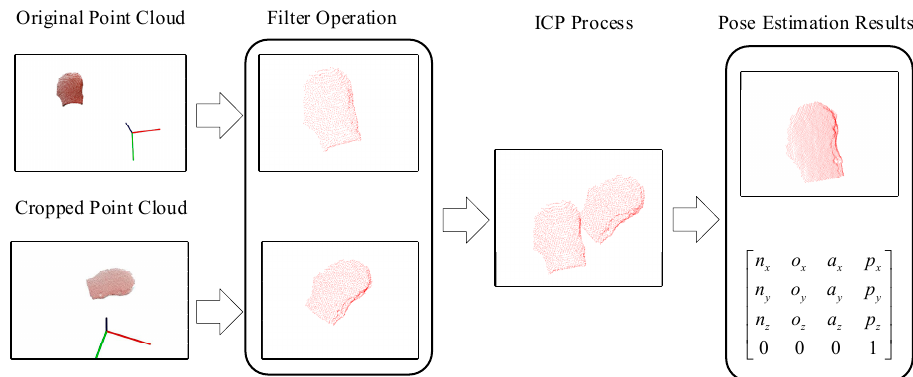
Figure 4. Pose estimation schematic. In the front-end loading process, the overlap ratio between the surfaces of each workpiece can be guaranteed for the robot grasping task, which provides sufficient initial conditions for the point cloud registration. We first preprocess the segmented and the initial point clouds by removing the scattered points and downsampling to reduce the amount of point cloud data while keeping the surface features of the workpieces unchanged. Then, we use the Iterative Closest Point (ICP) method to minimize the registration error and output the rigid transformation matrix between the two point clouds.